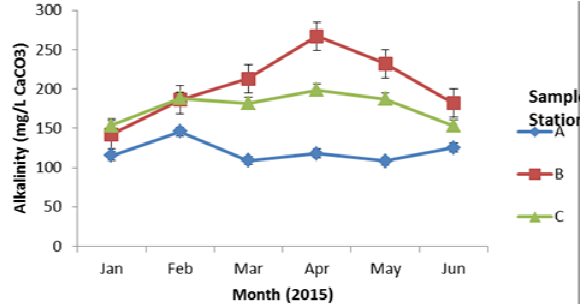
Fig. 6. The monthly mean variation in the acidity (mg/L CaCO ) of the water sampled from Saba River 3